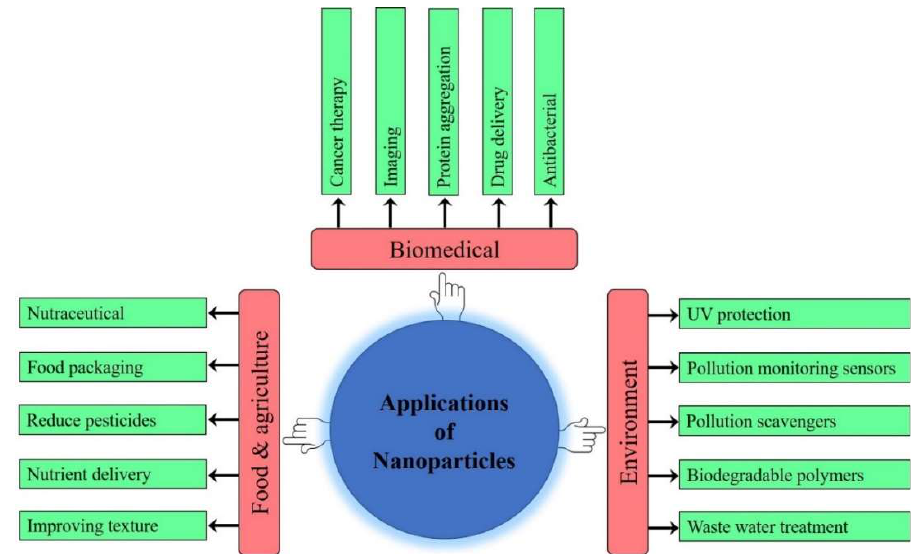
Figure 3. Applications of NPs in different fields.